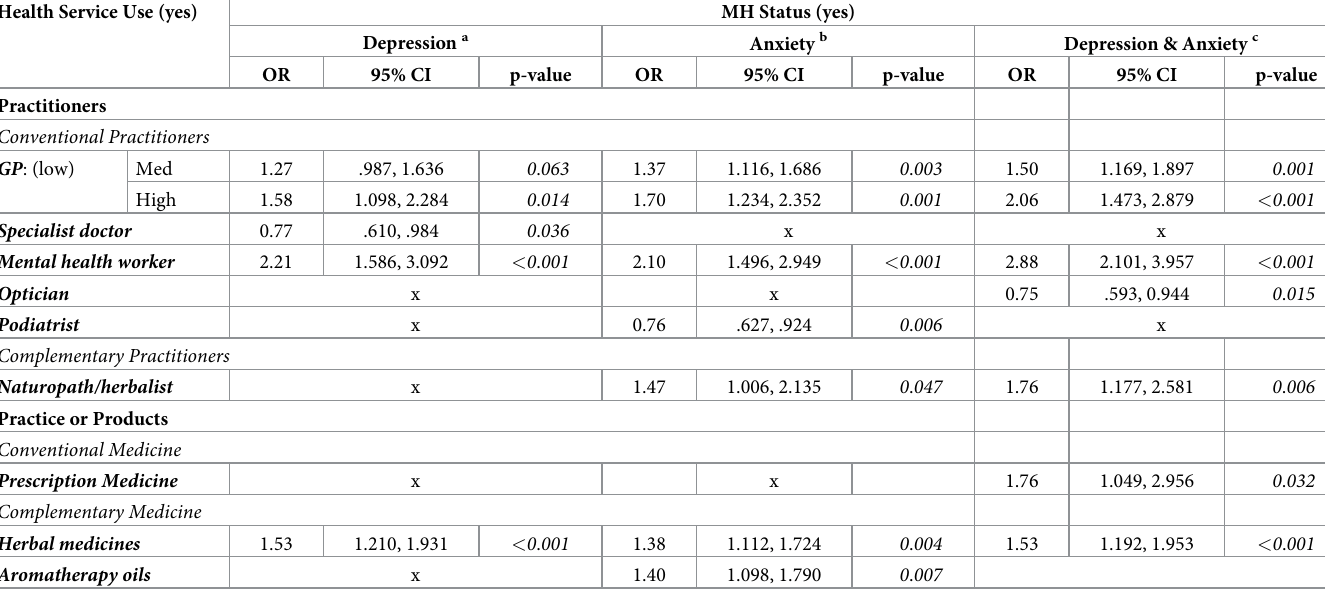
Table 4. The longitudinal association between mental health status and health service use by women with DM mellitus (2007–2013), as determined by generalized estimating equations (GEEs). Health Service Use